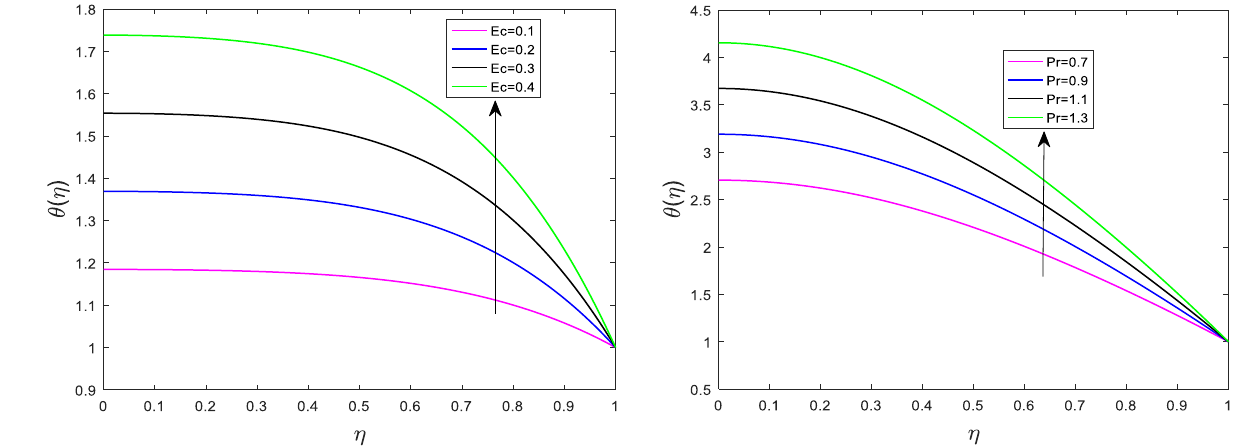
Figure 22: Effect of Ec on θ ( η ) for fixed S = Ω C = N t = Ec = Kr = 0.1, Ha = 0.2, N